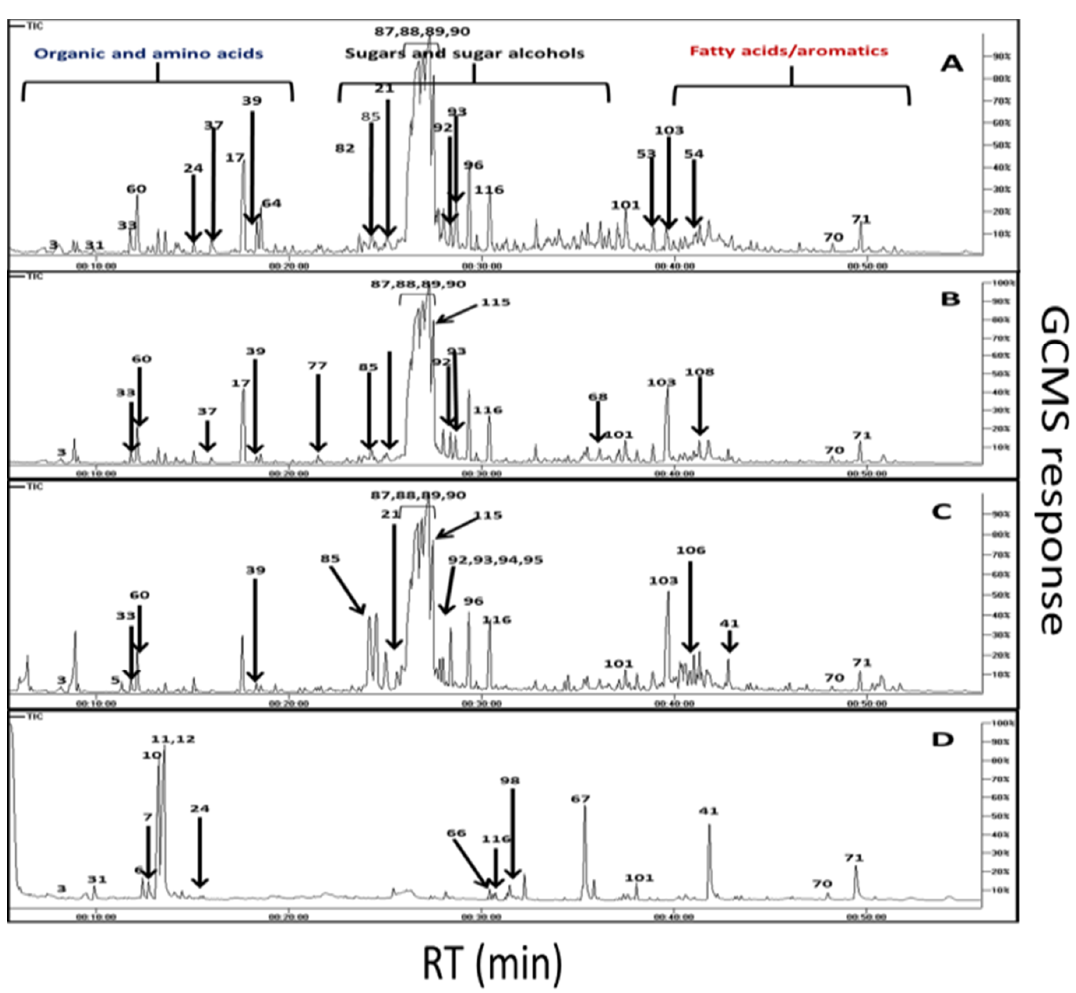
Figure 1. Gas chromatography coupled with mass-spectrometry (GC-MS) total ion chromatograms (TIC) of silylated metabolites in ripe fruit grown in Indonesia ( A ), Malaysia ( B ), Egypt ( C ) and unripe from Egypt ( D ).